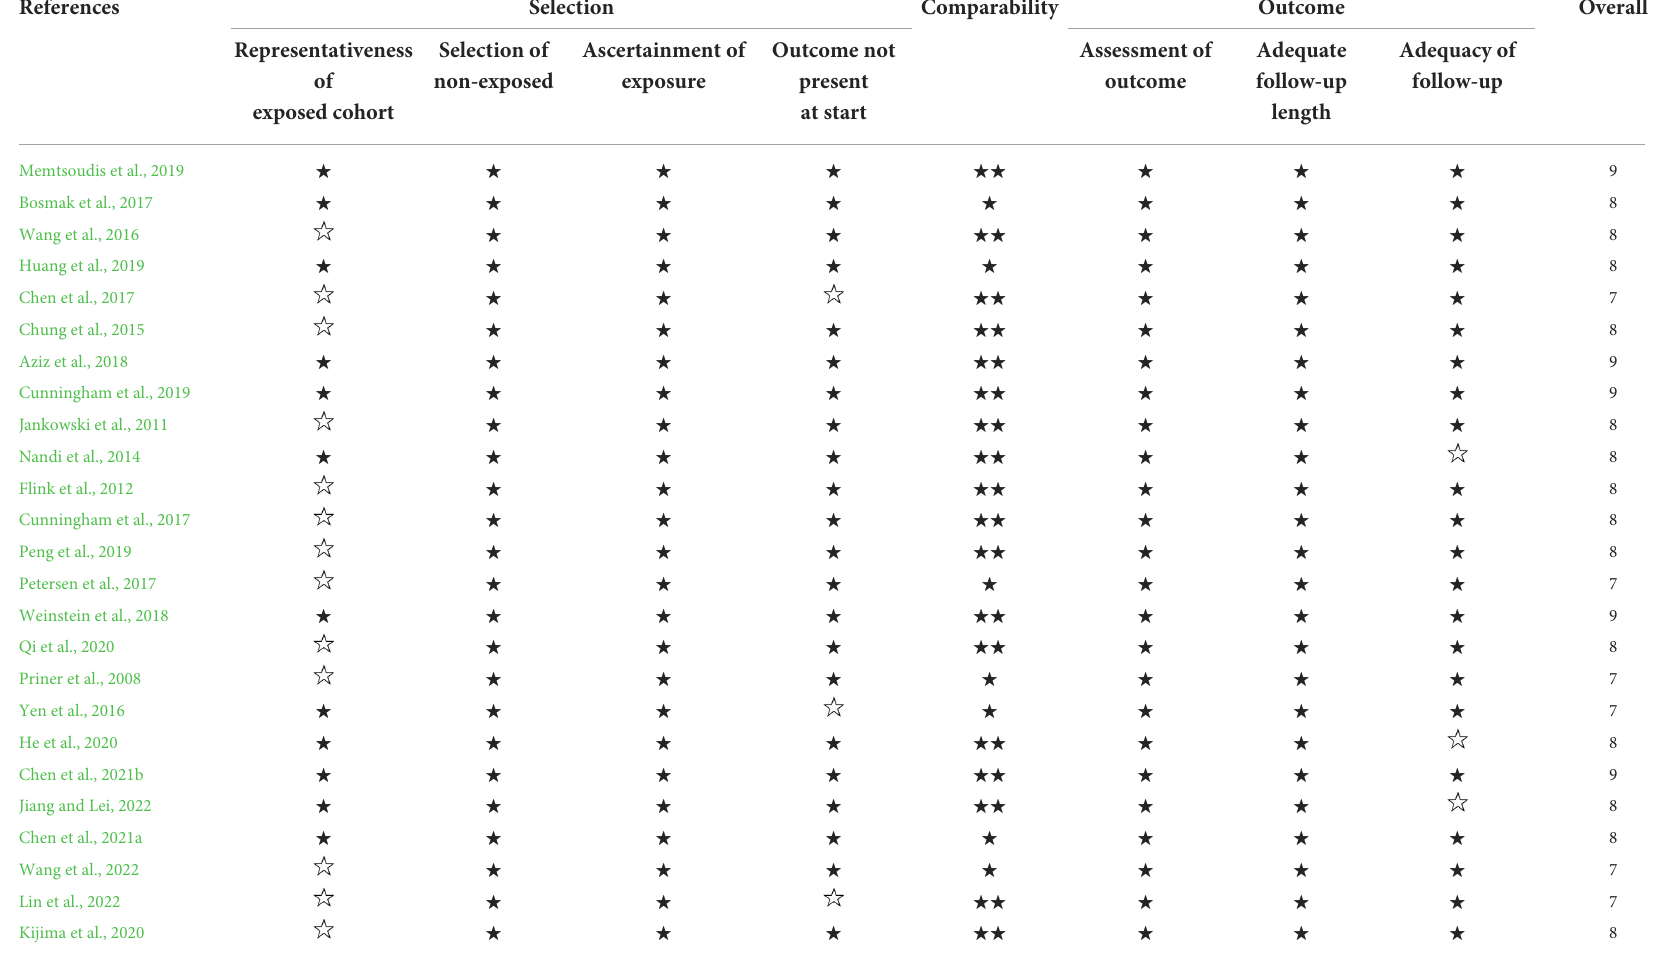
TABLE 2 Newcastle-Ottawa scale for risk of bias assessment of cohort studies included in the